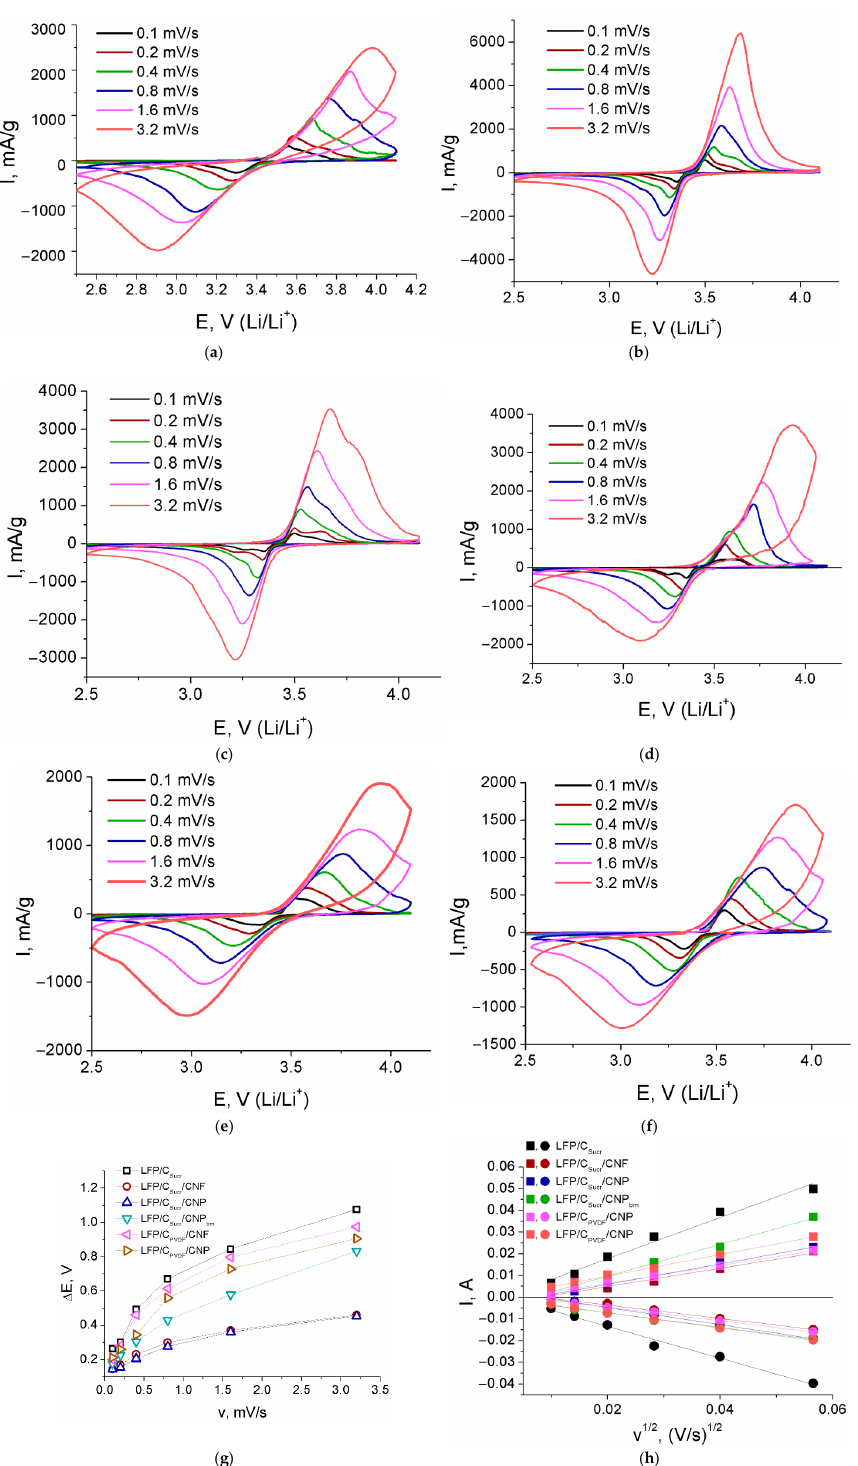
Figure 4. Cyclic voltammograms at different potential sweep rates for the LFP/C Sucr ( a ), LFP/C Sucr /CNF ( b ), LFP/C Sucr /CNP ( c ), LFP/C Sucr /CNP bm ( d ), LFP/C PVDF /CNF ( e ), and LFP/C PVDF /CNP ( f ) samples; the potential difference between the cathodic and anodic current peaks ( g ); the dependence of the peak current on the square root of the scan rate ( h ). Circles corre- spond to LFP reduction; squares correspond to LFP